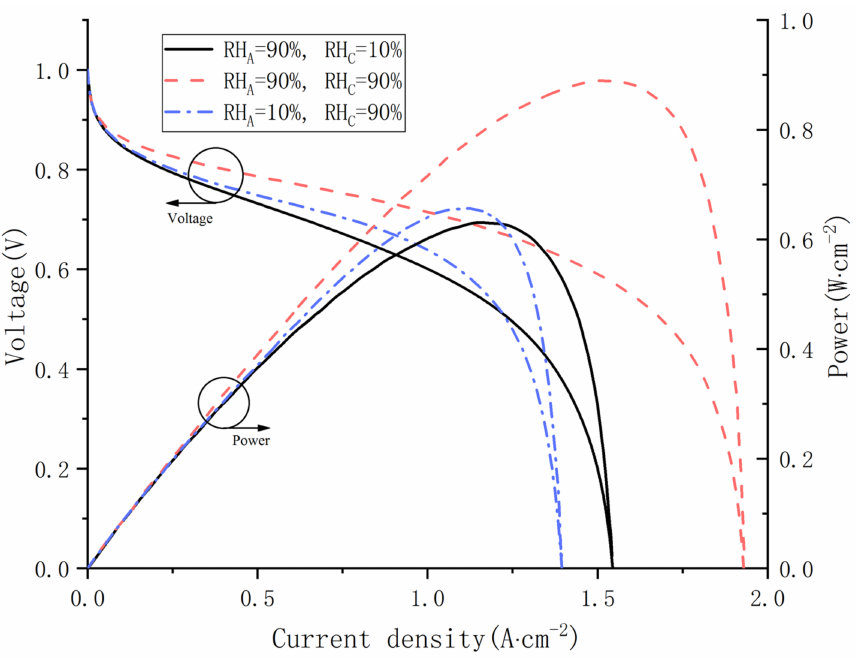
Figure 8. Polarization curves and power curves under various inlet relative